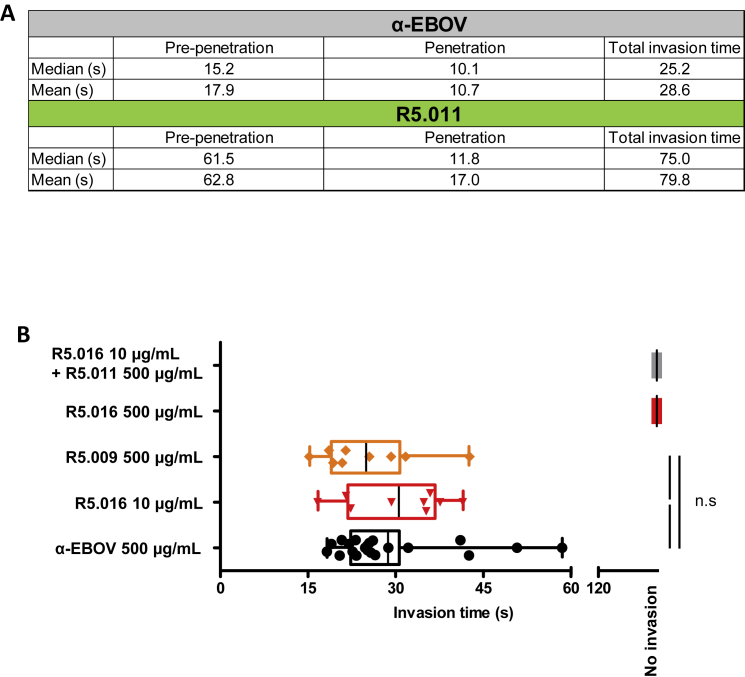
Additional Information from Live-Cell Microscopy Experiments, Related to Figure 7 and Videos S1, S2, and S3(A) Mean and median early (pre-penetration), late (penetration) and total invasion times of merozoites incubated with 500 μg/mL of R5.011 or α-EBOV. (B) Total invasion times of merozoites in the presence of neutralizing mAb R5.016 (red), synergistic mAb combination R5.011 + R5.016 (gray), non-neutralizing, non-potentiating mAb R5.009 (orange) or α-EBOV (black) mAb at the concentrations indicated. Data are representative of n = 9 invasions for R5.009, R5.016 10 μg/mL and R5.016 + R5.011, n = 12 for R5.016 500 μg/mL, n = 21 for α-EBOV and are presented as box-and-whiskers plots showing the interquartile range and total range overlaid on individual data points. Solid black lines show the mean for each group. 3D7 clone P. falciparum parasites were used. n.s = non-significant.